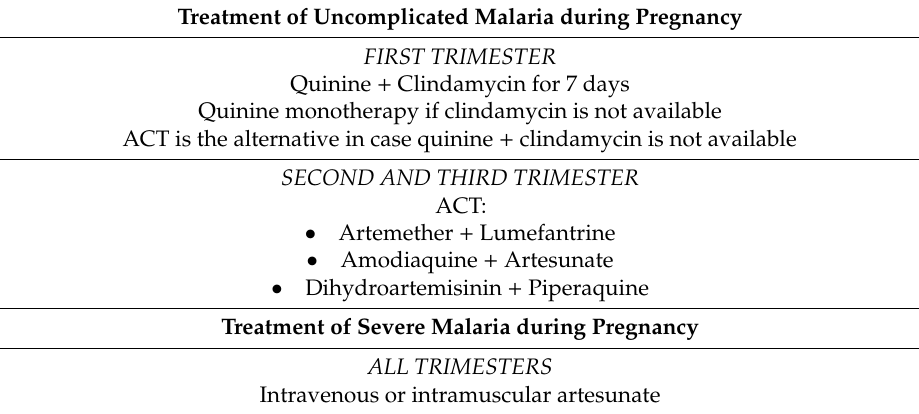
Table 1. Recommended treatment for P.falciparum malaria during pregnancy (WHO, Guidelines for treatment of